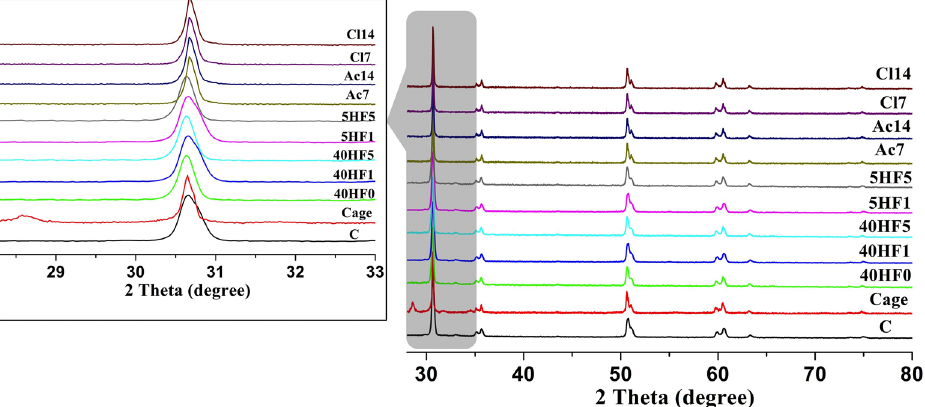
Fig 3. X-ray diffraction (XRD) patterns of specimens from the 11 groups. The m-phase of pure zirconium dioxide is detected at 27.5 – 28.5° 2 θ (arrow) in the low-temperature degradation (LTD) group only. No m -ZrO 2 is detected in the other groups. The left panel shows the XRD patterns at 27 – 33° 2 θ .